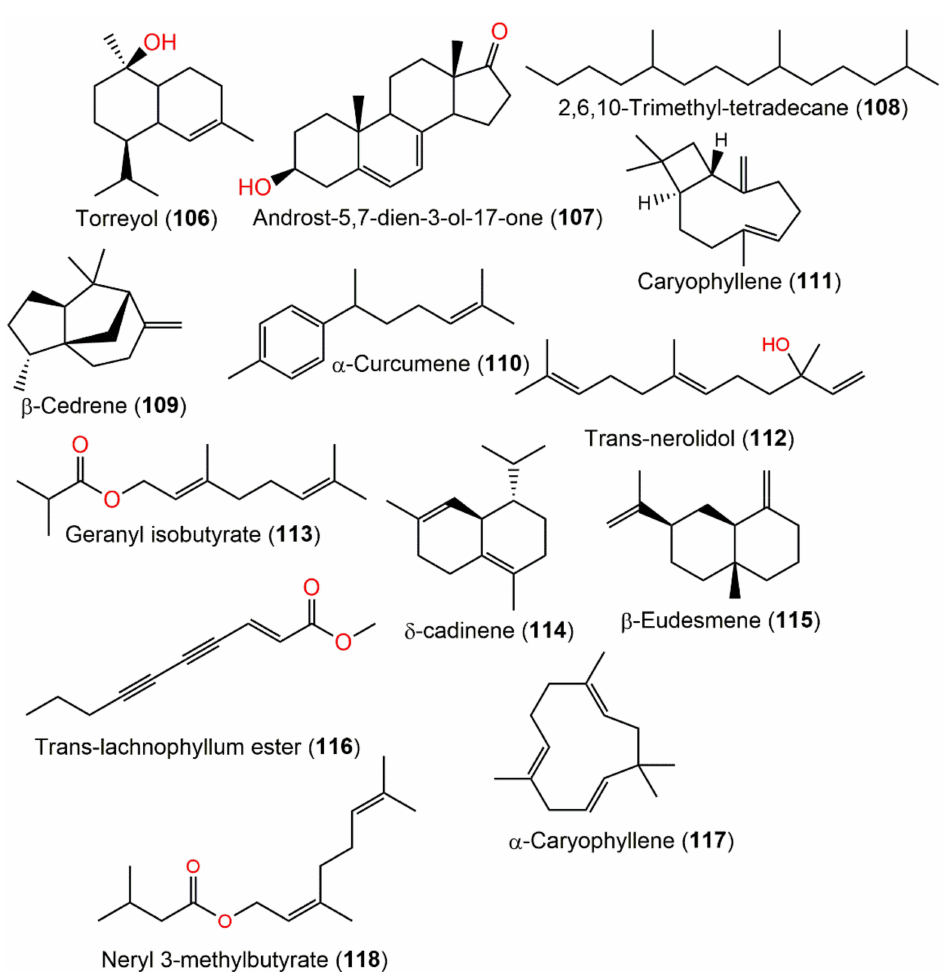
Figure 15. Structures of some volatile metabolites ( 106 – 118 ) reported from C. abrotanoides